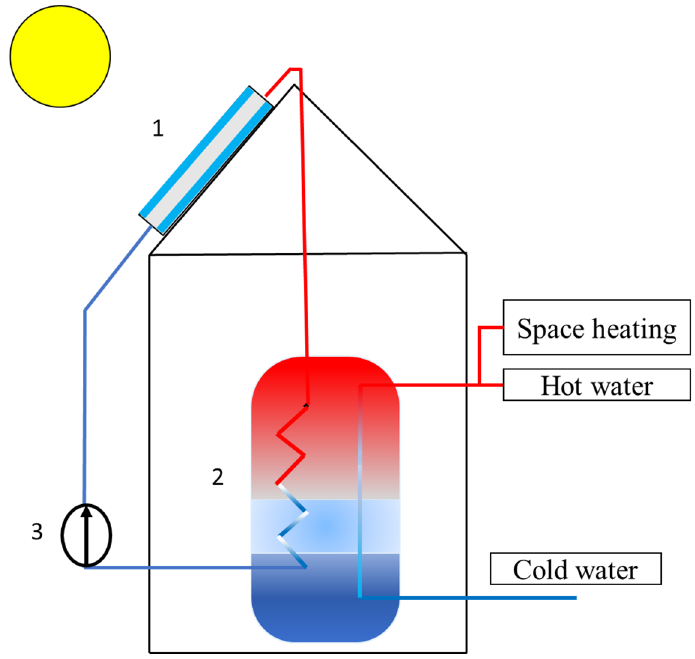
Figure 11. Meeting heating demands with solar thermal in residential building (1—solar thermal collector, 2—TES tank, 3—pump). collector, 2—TES tank,